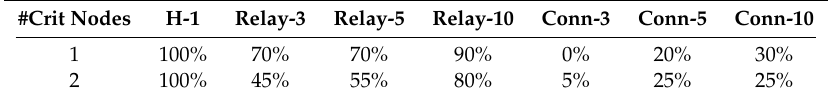
Table 2. Independent feature success rate for the top 3, 5 and 10 thresholds for the latency model. H = 1 is enough for 100% success rate.